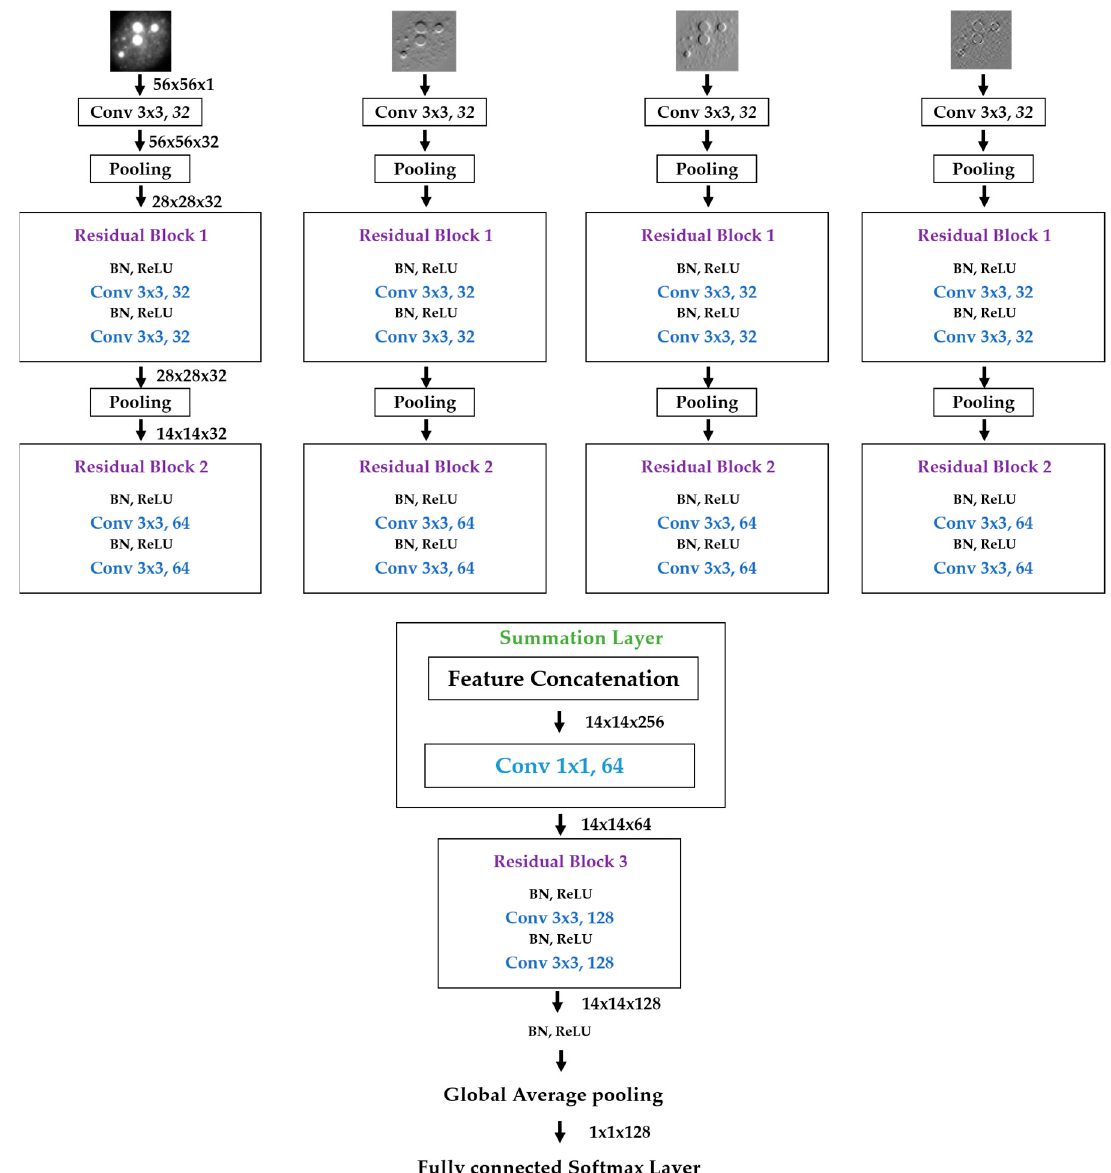
Figure 8. Summary of the architecture of the proposed scheme.